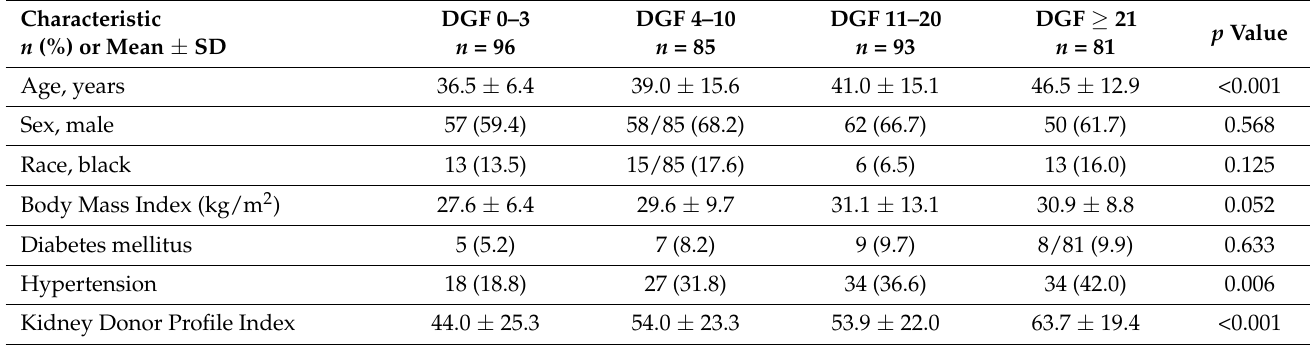
Table 1. Donor characteristics across DGF duration groups ( n =